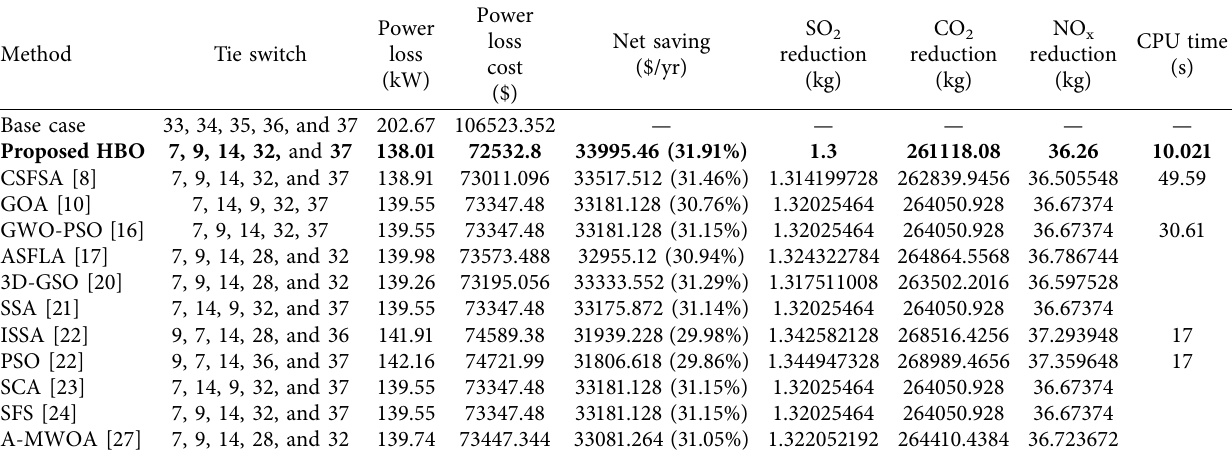
Figure 6: Each line loss in a 33-bus system with light load before and after reconfguration. Table 6: Result comparison of proposed HBO with other methods for the 33-bus system.